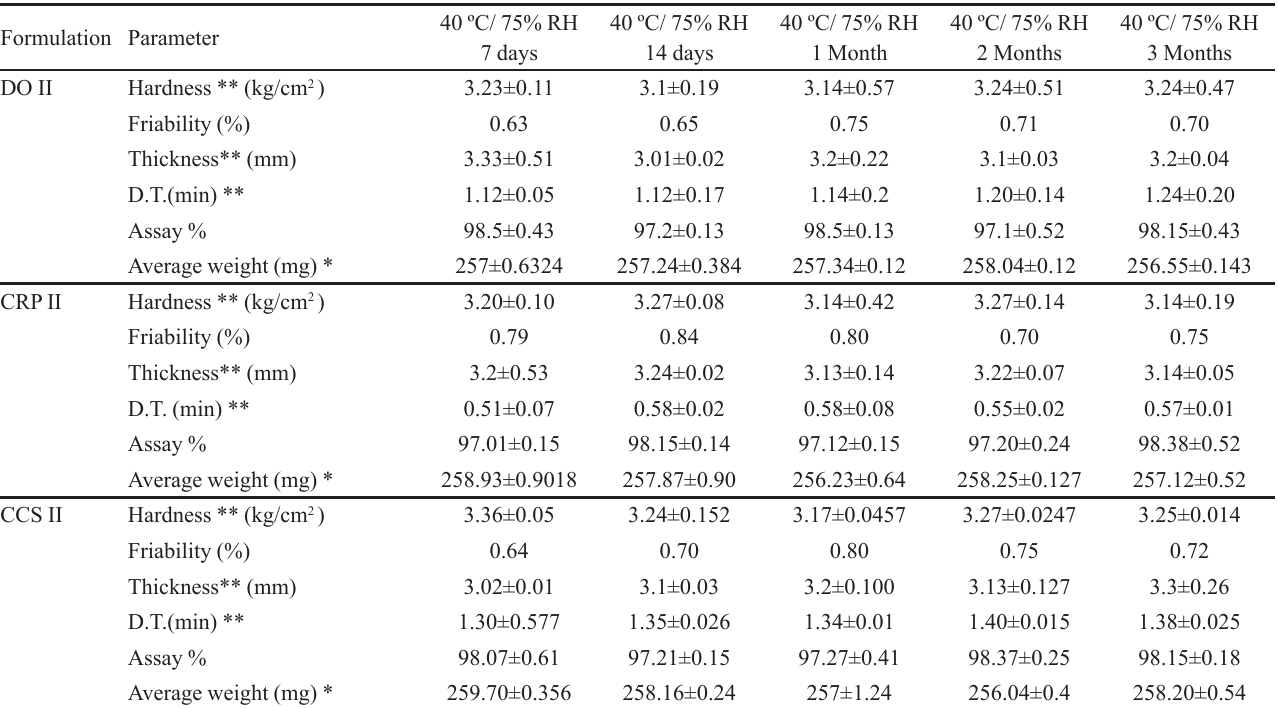
TABLE IX - Stability testing - ii) 40 ± 2 O C and RH 75 % ± 5% Formulation Parameter